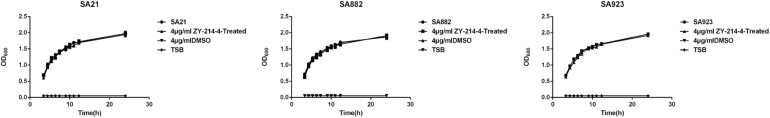
Growth curves of S. aureus strains cultured with ZY-214-4. TSB served as a blank control, and growth in the presence of DMSO was evaluated to eliminate the possibility that inhibition of biofilm formation is due to suppression of cell growth.